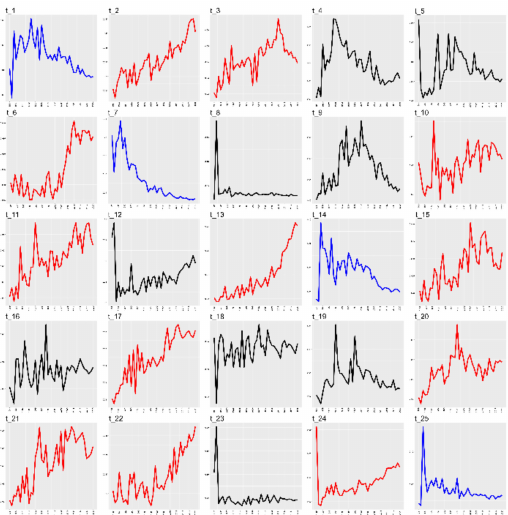
Figure 6. Trend of topics.